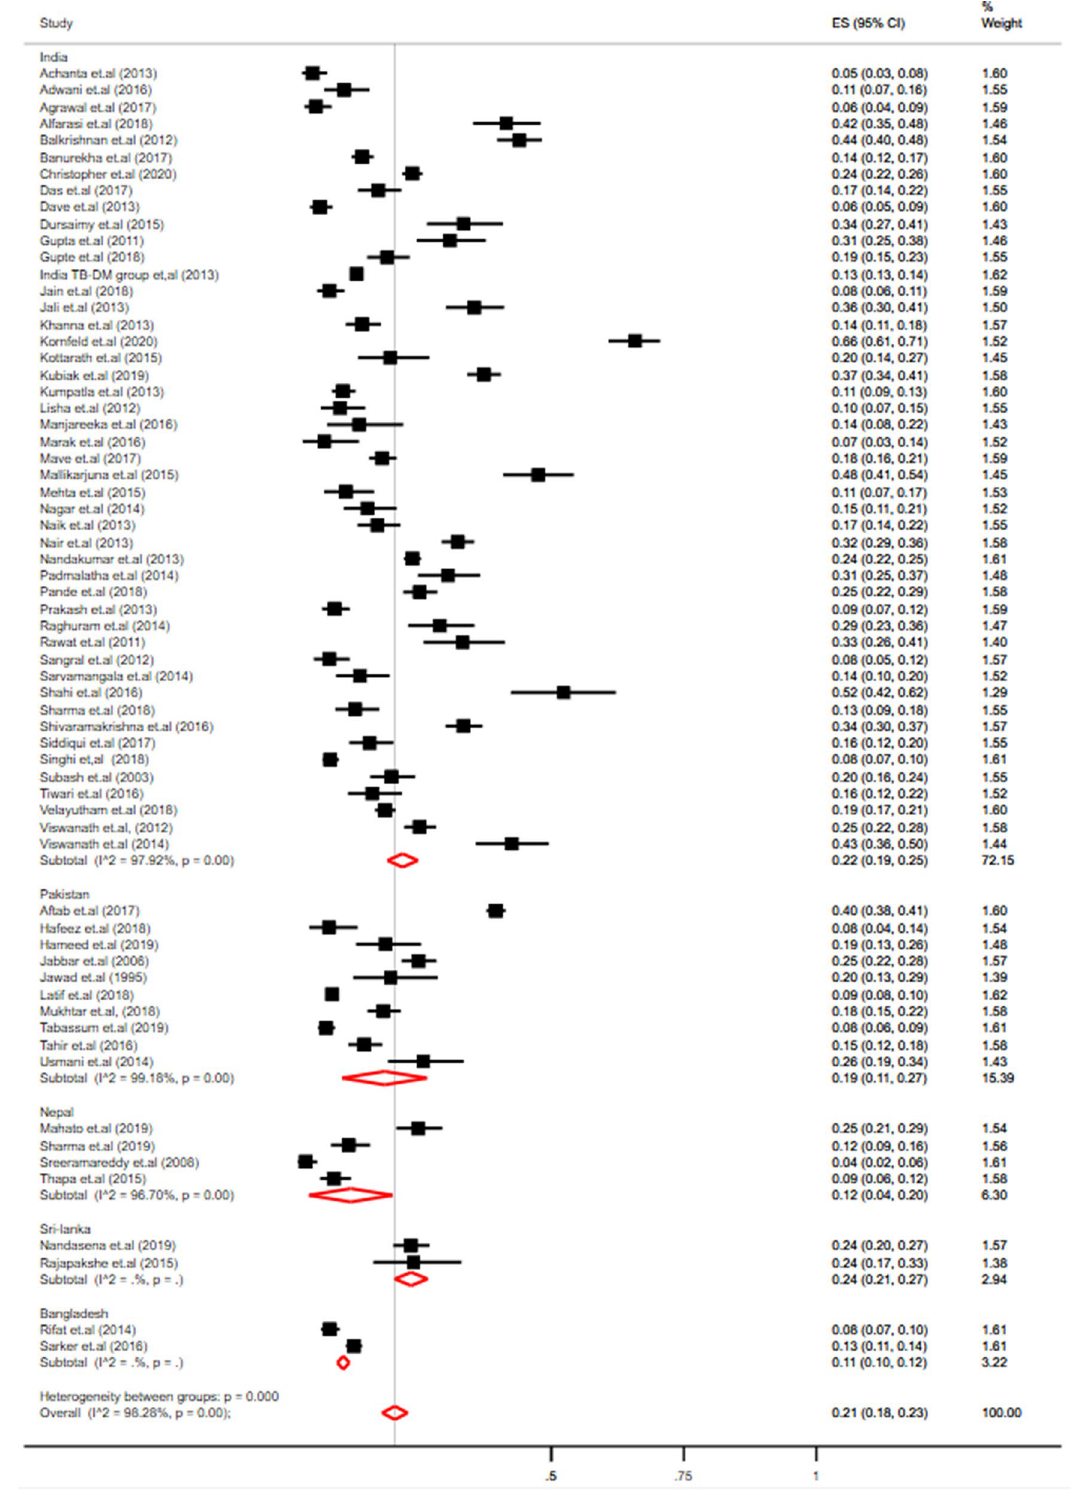
Figure 1. Forest plot for the pooled prevalence of diabetes among tuberculosis patients in South